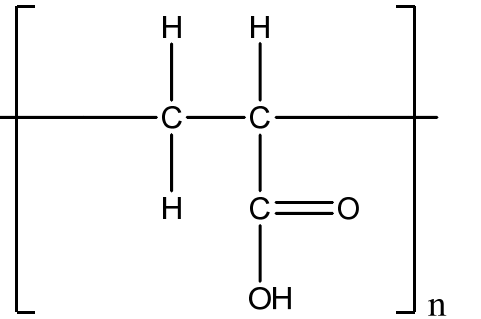
Figure 1. Chemical structure of a monomeric unit of acrylic acid in a carbomer polymer.